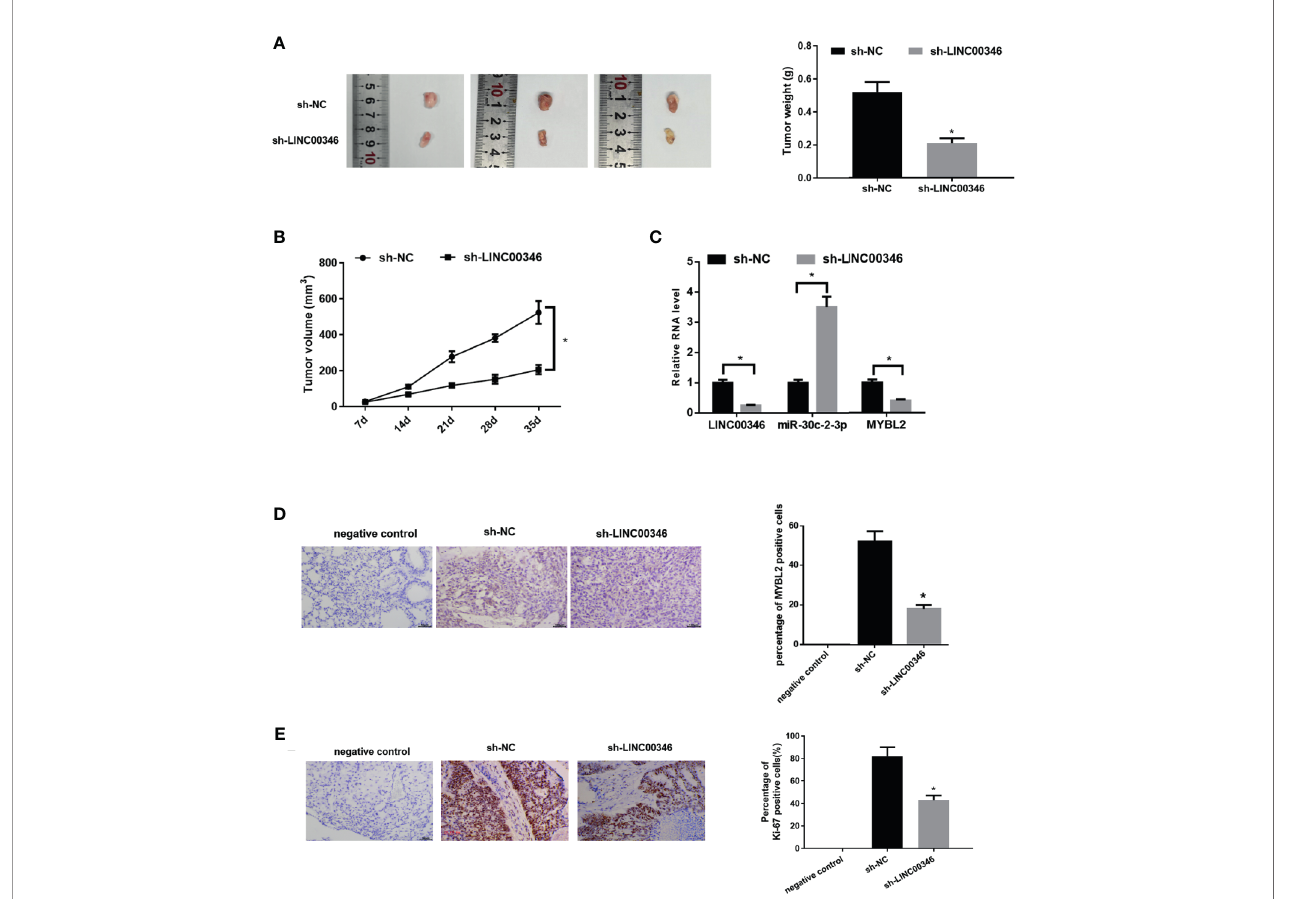
FIGURE 7 | Knockdown of LINC00346 inhibits the growth of LUAD. (A) Xenograft tumors were photographed and tumor weight was measured from nude mice after 35 d; (B) Tumor volume was measured weekly; (C) The expressions of LINC00346, miR-30c-2-3p and MYBL2 in tumor tissues were determined by qRT-PCR; (D, E) IHC detected the number of Ki-67 positive cells in xenograft tumor tissues (400×). * P <